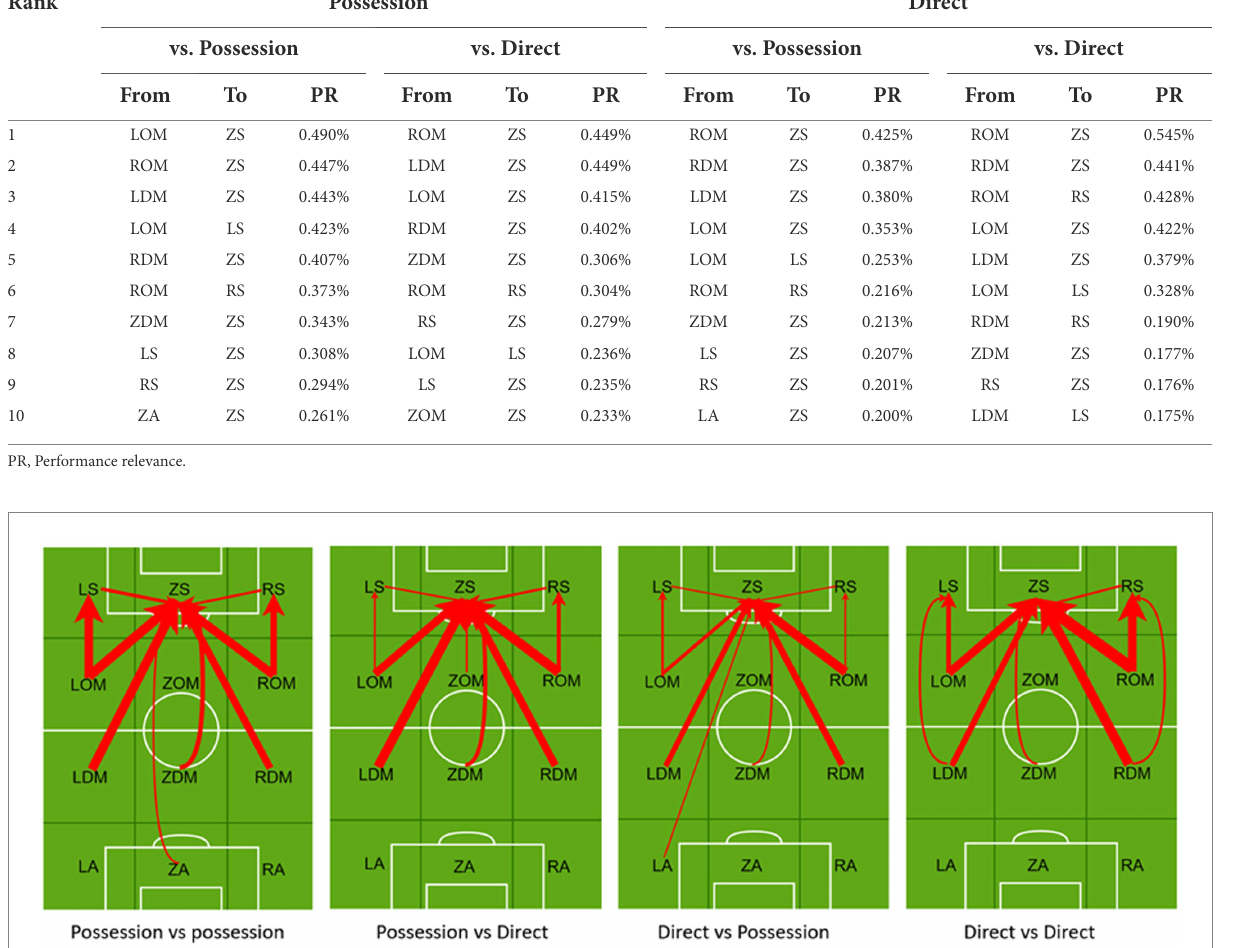
TABLE 3 Diagnostical analysis of passing routines among top three teams in the World Cup 2018.